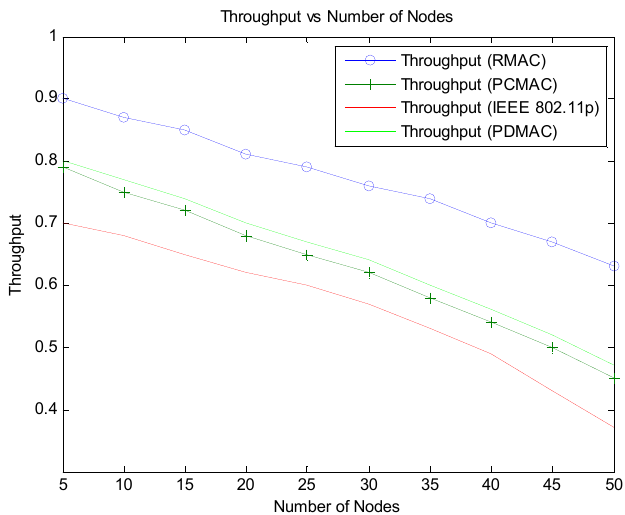
Figure 9. Throughput vs. number of nodes.